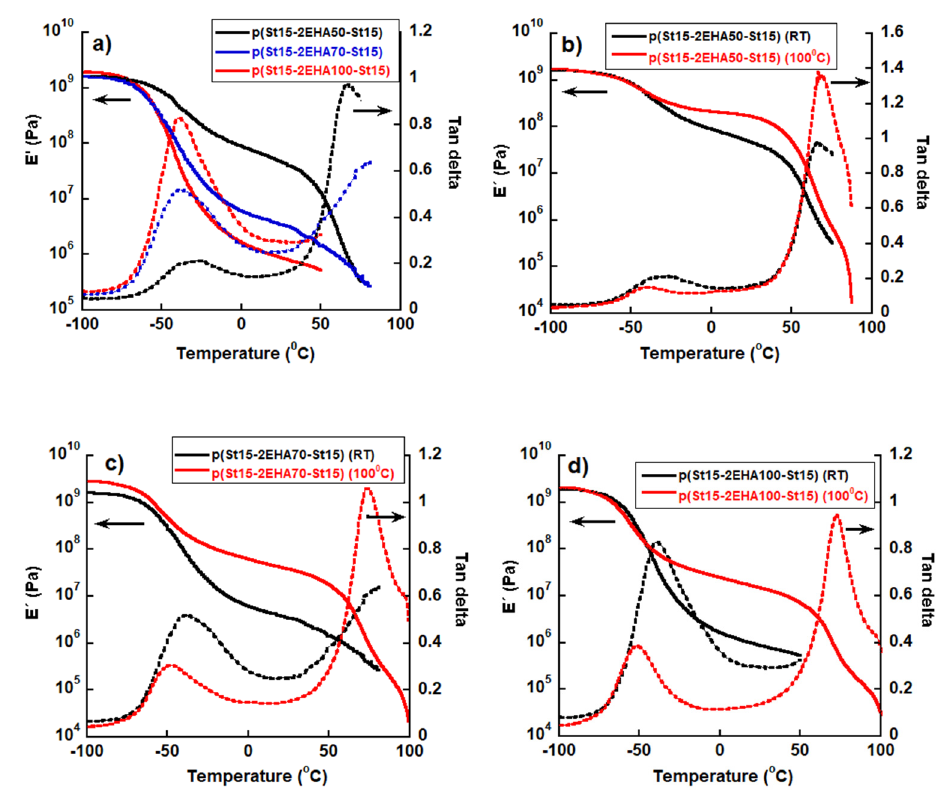
Figure 11. Viscoelastic properties of the block copolymers. Solid lines: dependence of elastic modulus on temperature. Dashed lines: dependence of tan δ on temperature.